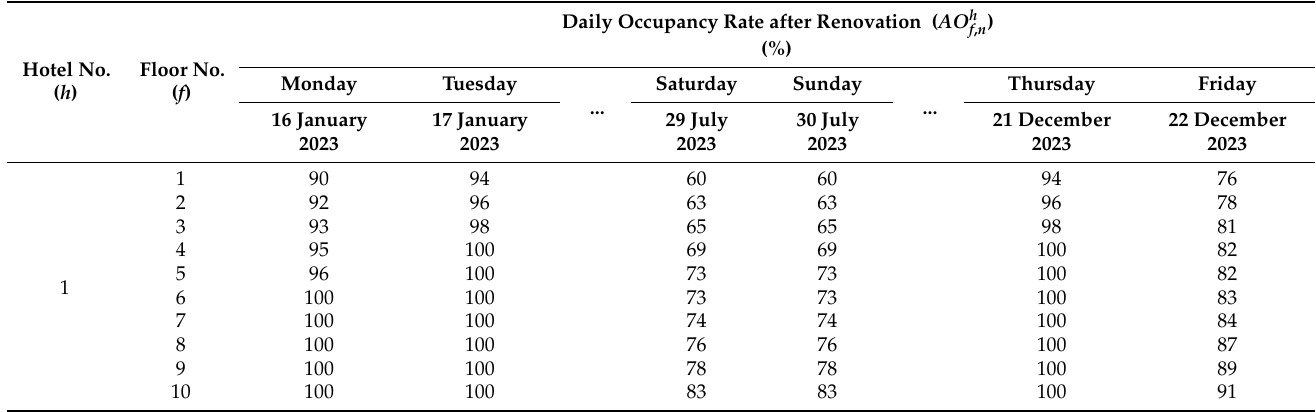
Table 5. Daily occupancy rates after renovation for sample